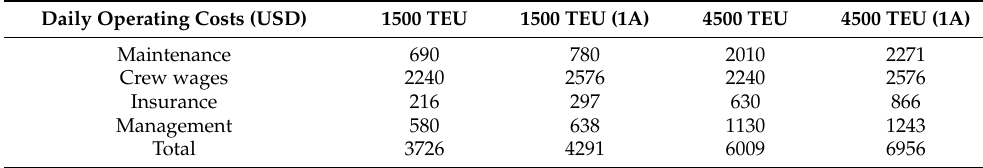
Table 2. Voyage costs based on different tonnage and ice class of the vessel.